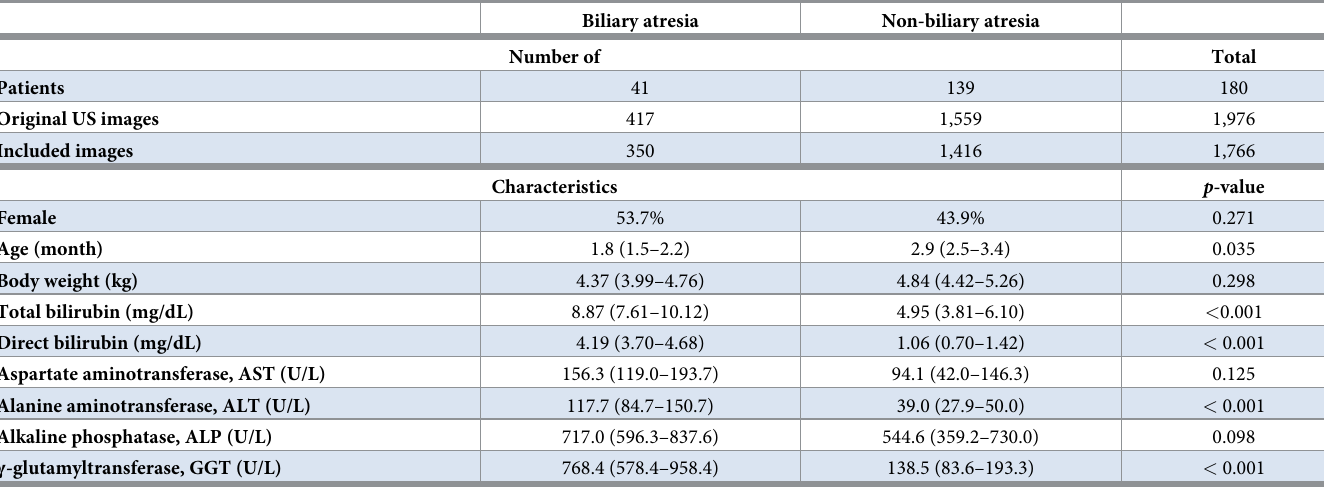
Table 1. Patients’ characteristics, patient number, and US images amounts of BA and non-BA groups.